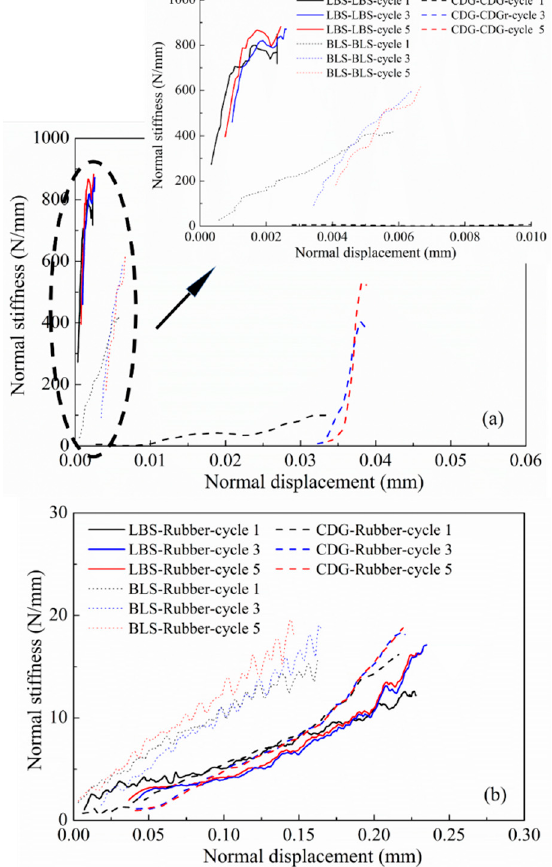
Figure 10. Normal contact stiffness of ( a ) rigid interfaces and ( b ) rigid–soft interfaces.